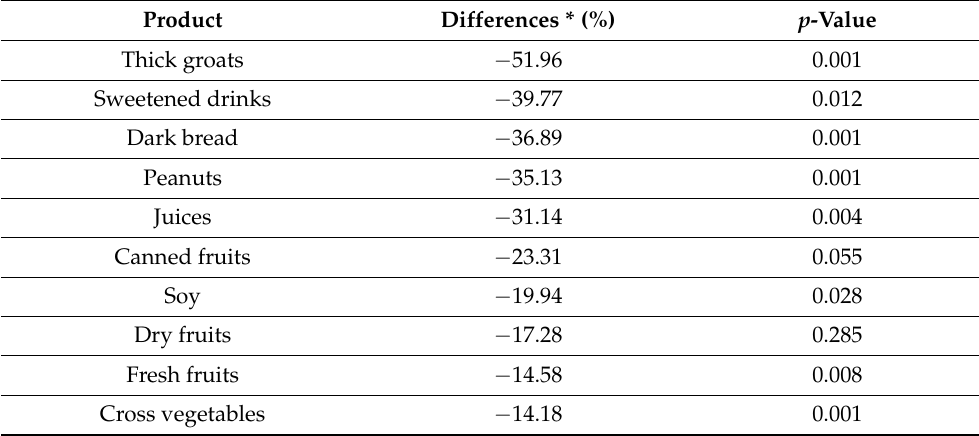
Table 4. The frequency of products consumed by patients with PD compared to healthy controls. Significance testing was performed using the R statistical package. Table 4 shows the products with lower intake in the PD group compared to the